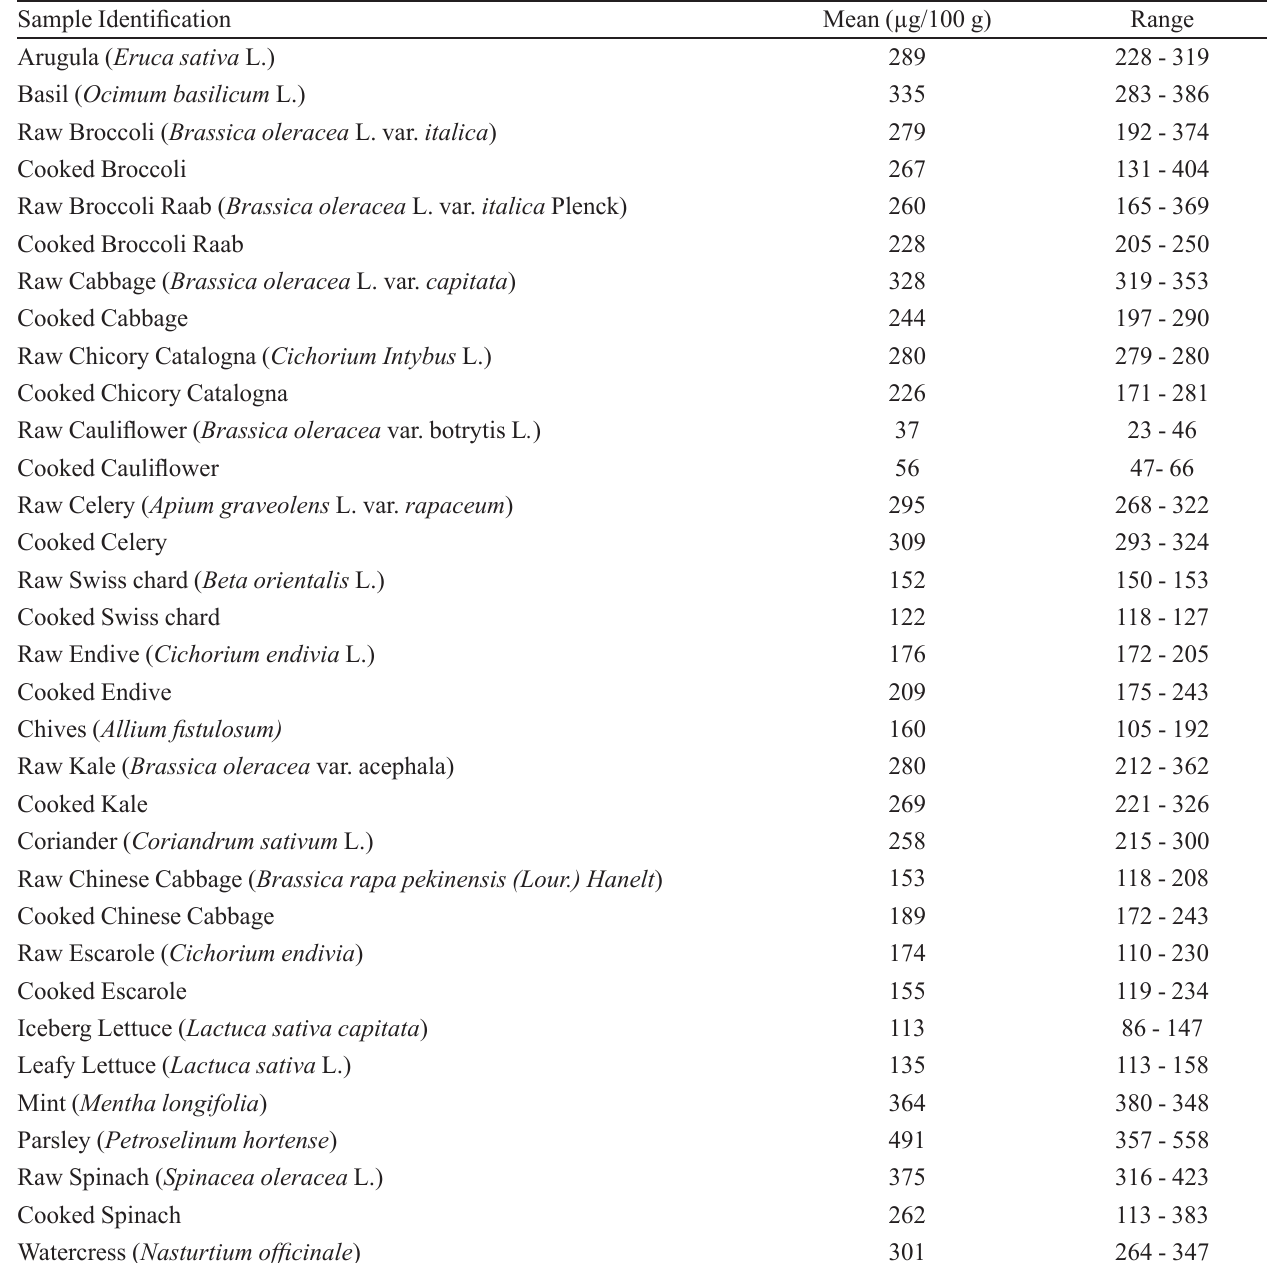
TABLE I - Concentration of phylloquinone in fresh and processed vegetables Sample